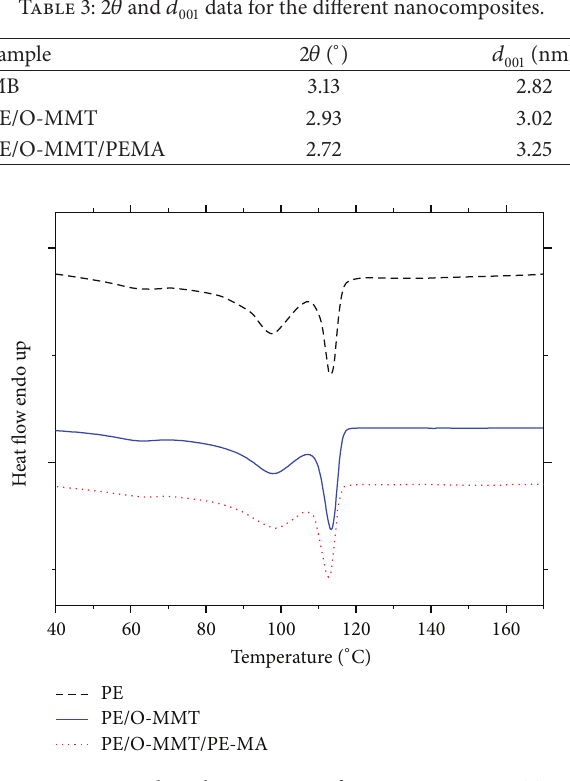
Figure 2: DSC cooling thermograms of neat PE, PE/O-MMT, and PE/O-MMT/PE-MA nanocomposites.